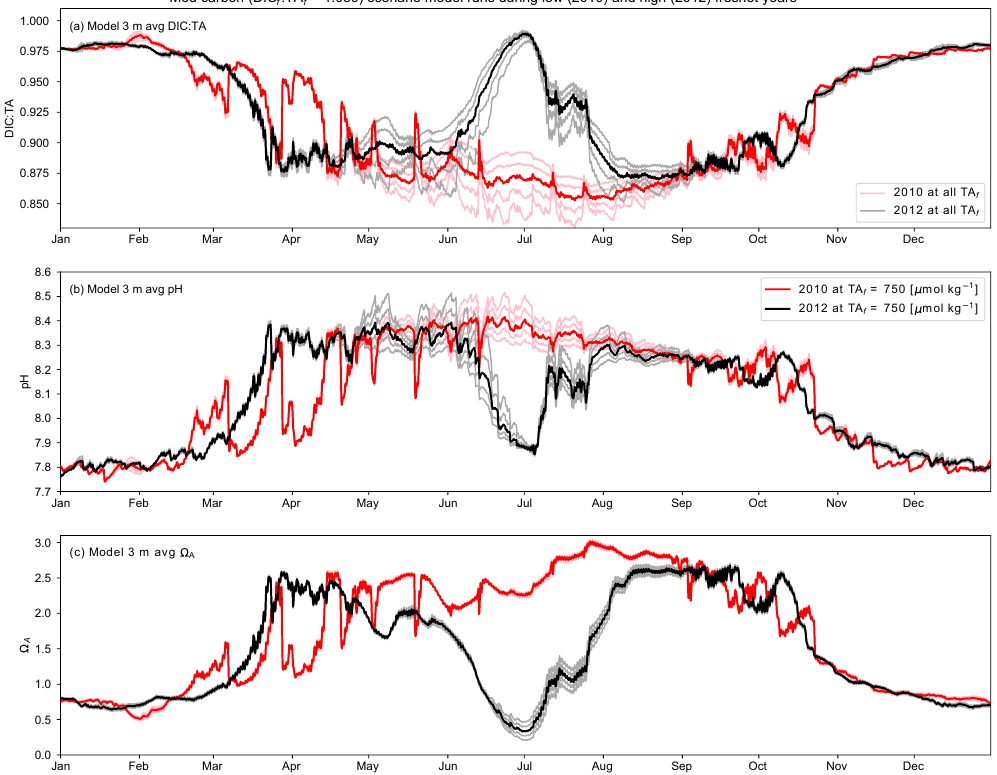
Figure 4. Time series of model top 3m averaged (a) DIC:TA, (b) pH, and (c) (cid:127) A for all TA scenarios (Table 2) during 2010 (red/pink curves) and 2012 (black/gray) curves under the Med Carbon scenario (DIC f :TA f = 1.089), colors consistent with Fig. 3. The bold curves show model results at TA f = 750µmolkg − 1 and the lighter curves show model results at all TA f . All three quantities demonstrate a seasonal cycle consistent with biologically driven DIC decreases in summer, increases in winter, and variations in spring associated with the spring bloom season. A strong mid-summer DIC increase is present in the 2012 results when river discharge is strong, but absent in the 2010 results when river discharge is